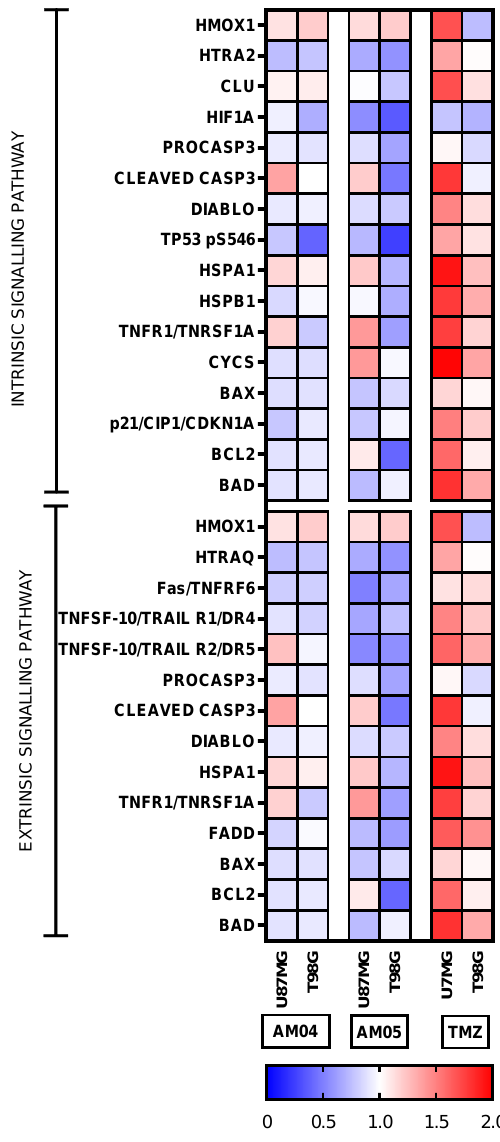
Figure 5. Proteome profiler of protein-related to apoptosis based on antibody array. Performed for duplicates of antibody spots for each condition.